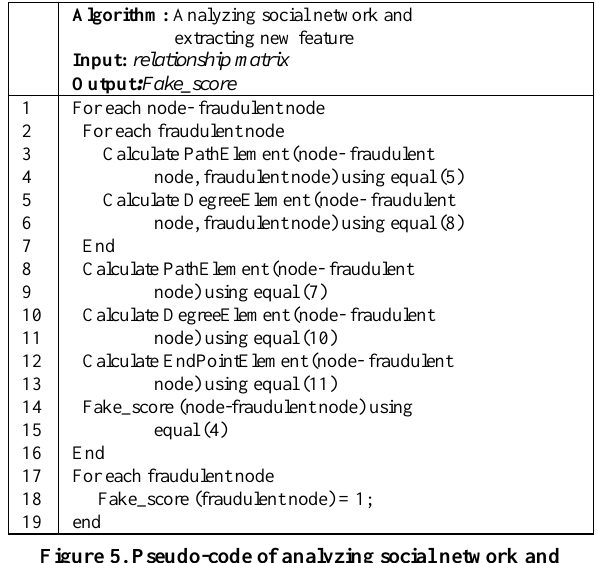
Algorithm: Analyzing social network and extracting new feature